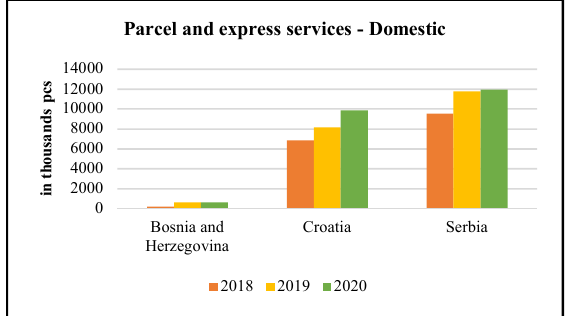
Figure 2. Parcel and express services in Domestic - Public postal